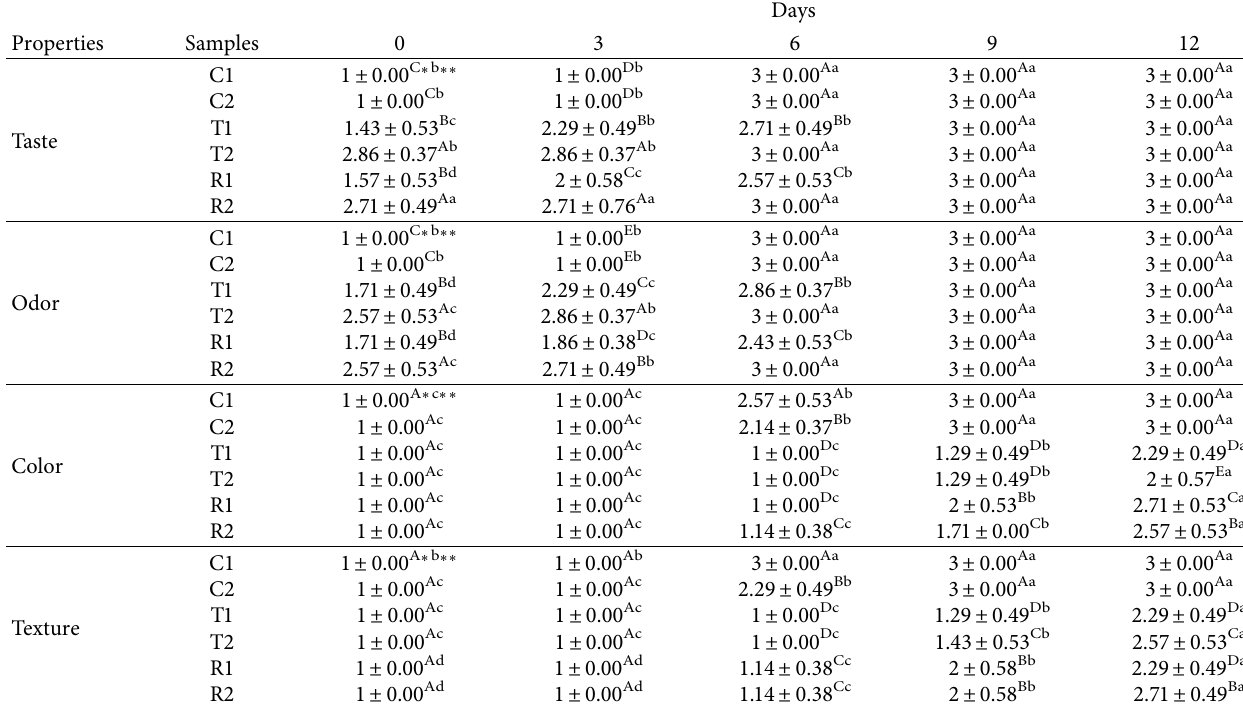
Table 4: Efect of thyme and rosemary EOs on sensory properties’ scores of vacuum-packaged chicken breast samples during refrigeration (mean ± SD).